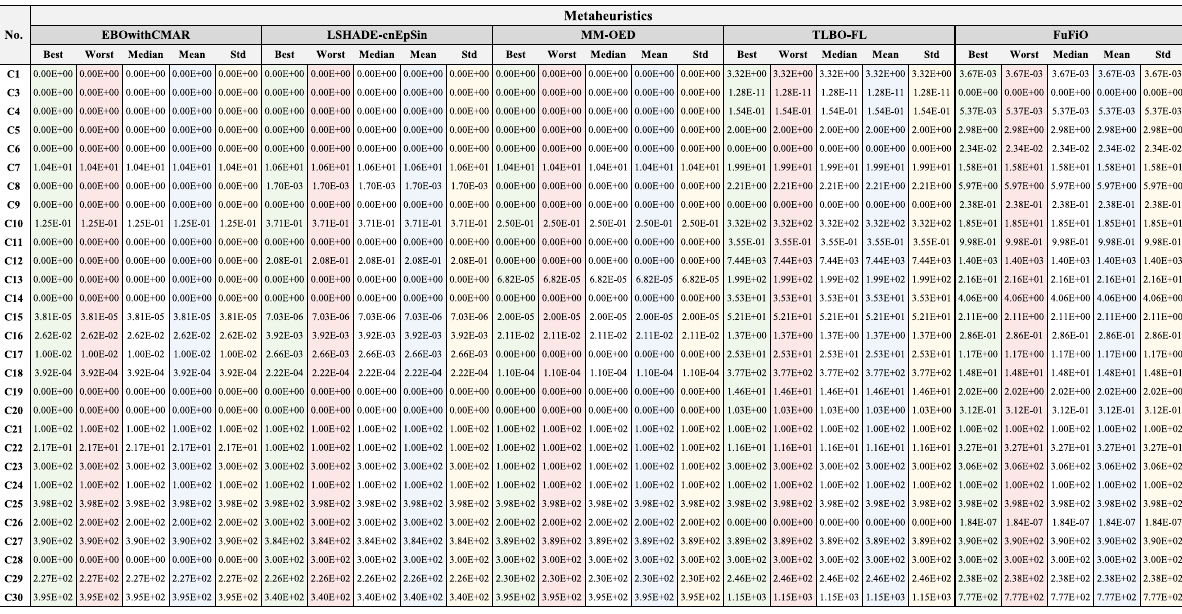
Table 13. Statistical results of different algorithms for the 10-dimensional CEC-2017